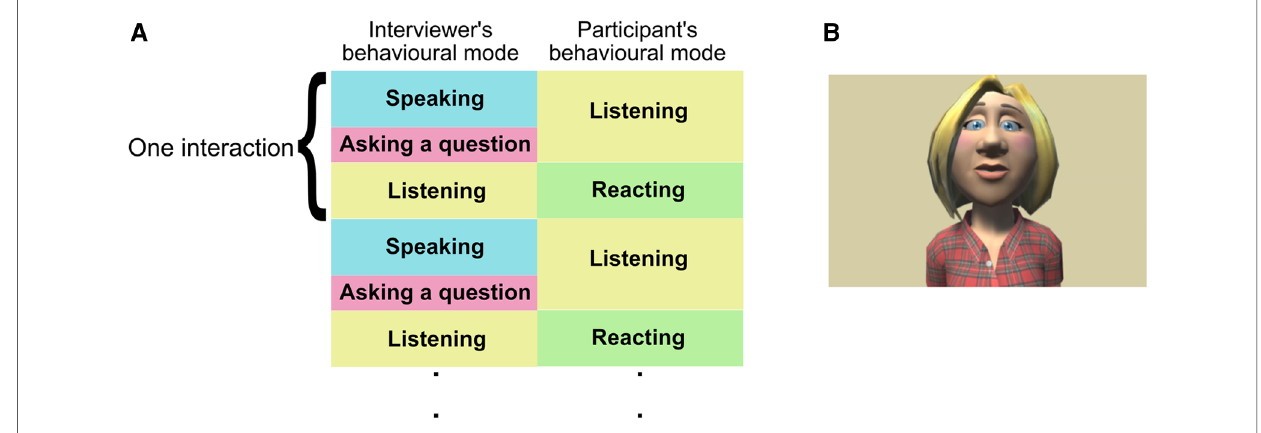
FIGURE 1 ( A ) Experimental fl ow and behavior modes of participants and interviewers and ( B ) the appearance of the virtual avatar